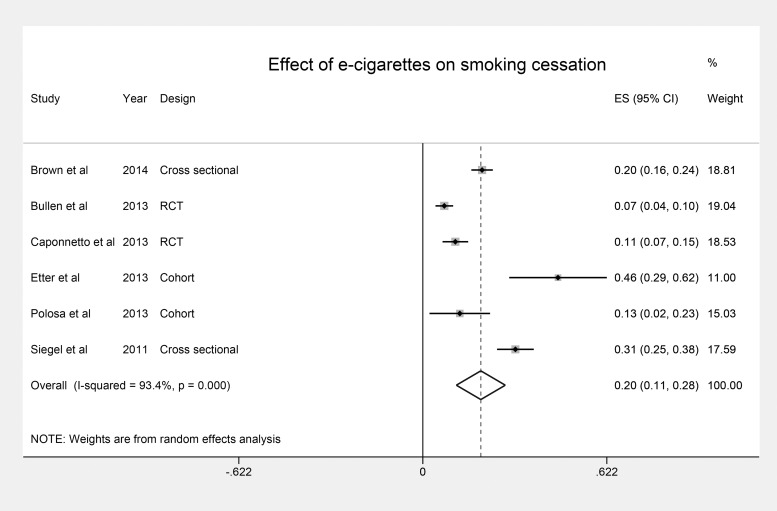
Forest Plot of the association between nicotine-enriched e-cigarettes and smoking cessation.